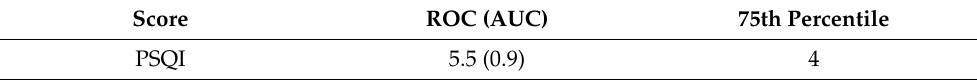
Table 2. Patient acceptable symptom state (PASS) for PSQI 1 .